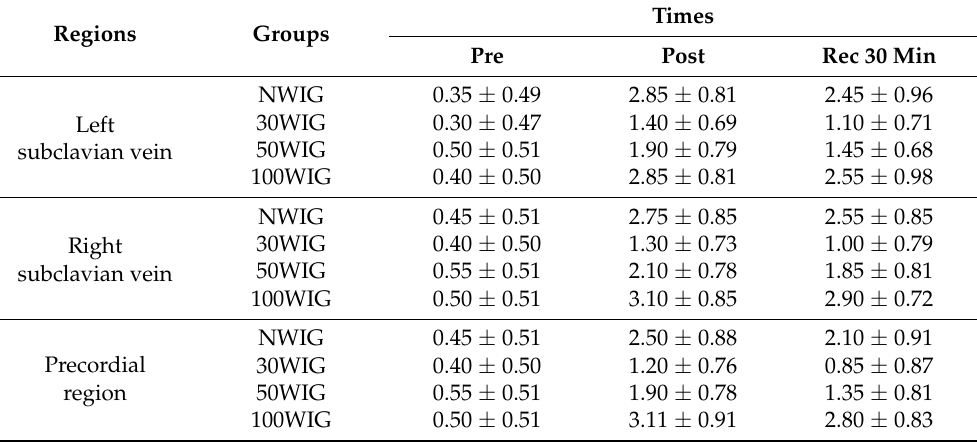
Table 4. Percentage * in the left and right subclavian veins and precordial region. Regions